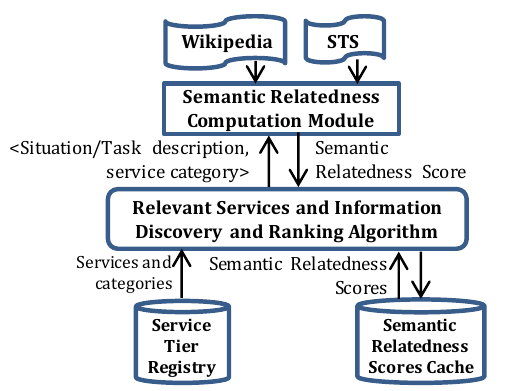
Figure 3: Pipeline for the Relevant Services and Information Discovery and Ranking Engine formation and sends it back to the Service Tier